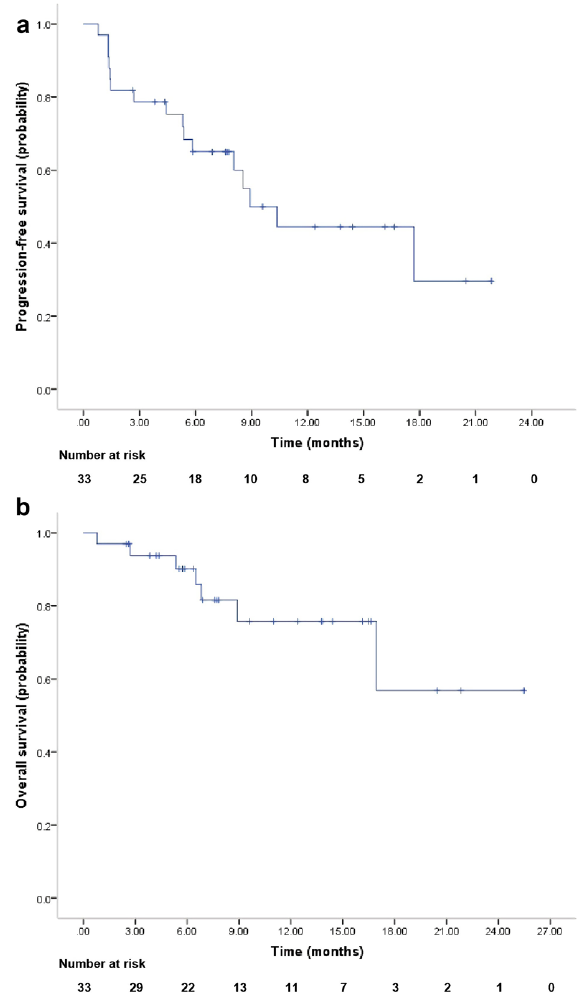
Figure 3. Kaplan–Meier curves for ( a ) progression-free survival and ( b ) overall survival in all 33